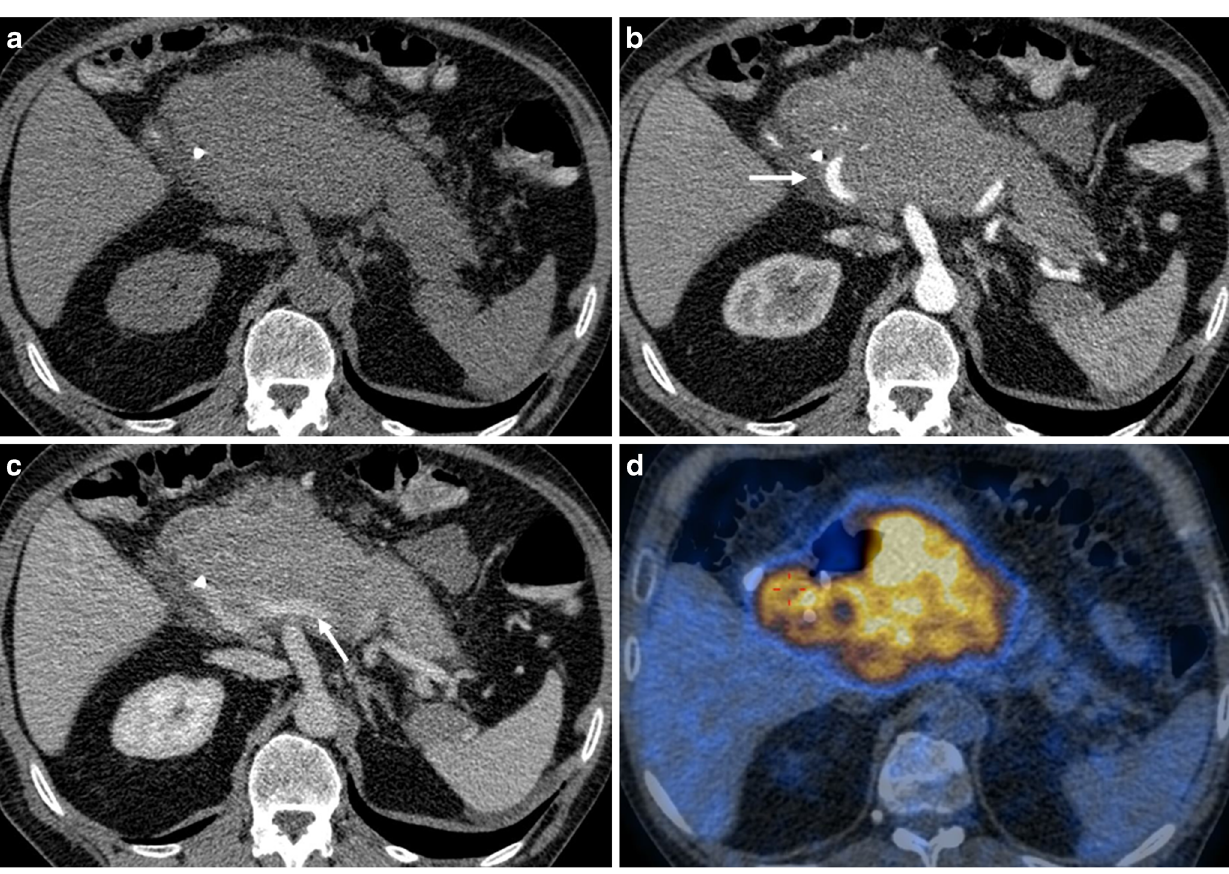
administration in the arterial-pancreatic phase ( a ) and portal-venous phase ( b ): the arteries and veins (arrows) are encased but not infiltrated. The main pancreatic duct is not enlarged. d This 18 FDG PET-CT fusion